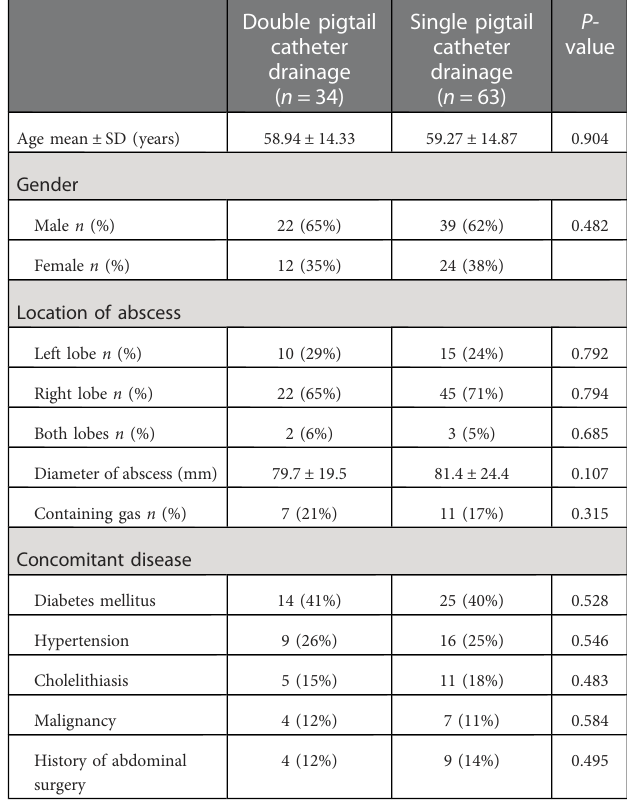
TABLE 1 Baseline characteristics of patients in the two